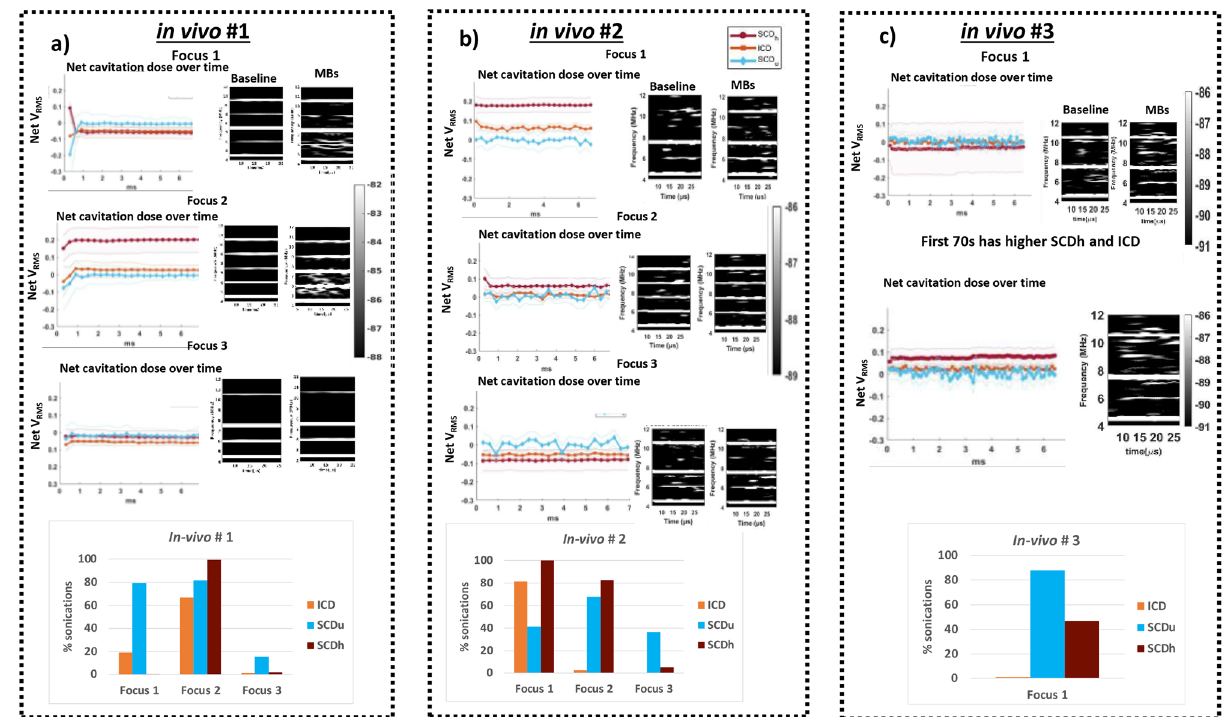
Figure 5. Cavitation dose analysis in our in vivo trials over 150 s of sonication. ( a ) In trial #1 where three foci were sequentially sonicated in a repeated manner, values of ICD and SCDh in focus 2 were greater after MBs administration, while focus 1 and focus 3 were comparable to baseline. Threshold analysis revealed that a total of 20% of sonications with focus 1 consisted of inertial activity and 66% consisted of ultra-harmonics activity that would be indicative of MBs activity (ie. at least 1 out of 23 pulses, and in some cases more than 1, resulted in inertial and ultra-harmonics activity which could be indicative of presence of MBs). ( b ) In trial #2, net values for ICD, SCDu and SCDh for focus 2 and focus 3, were near baseline, while echoes from focus 1 had greater values of ICD and SCDh after MBs administration. ( c ) In trial #3, we only sonicated using 1 focus and saw 88% of sonications above threshold in SCDu, 47% of sonications above SCDh threshold and, 1% of sonications above ICD threshold. Although average of 150 s sonication show doses comparable to baseline, in the first 70 s, SCDh and ICD were higher after MBs